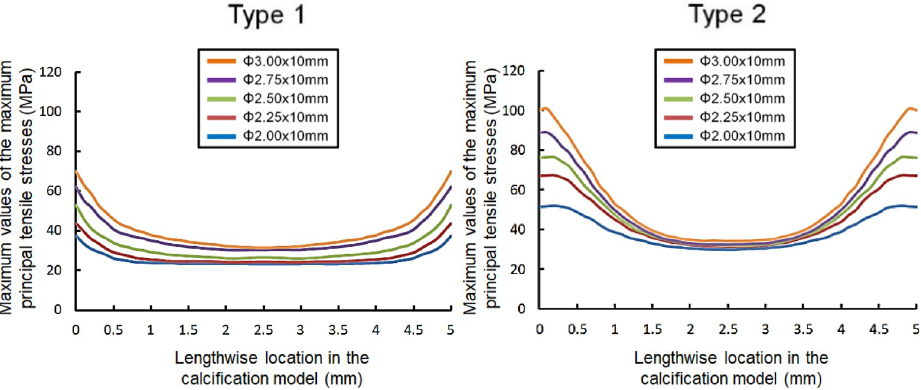
Fig 4. Peak values of the maximum principal tensile stresses in the calcification models along the longitudinal direction when the cutting balloon is inflated at the rated pressure (12 atm).